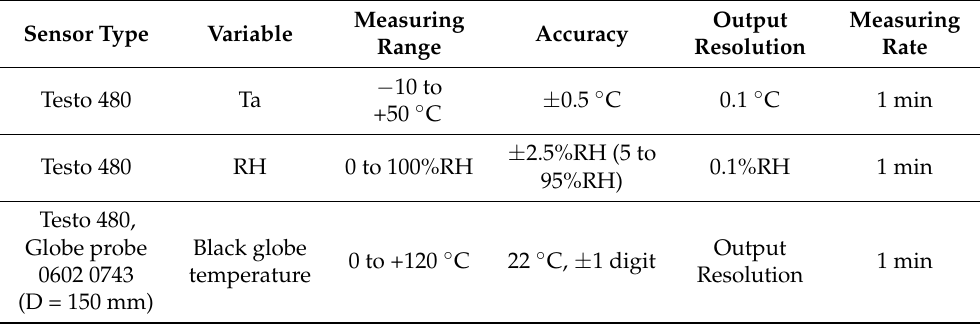
Table 5. Measuring instrument, specifications and technical data of